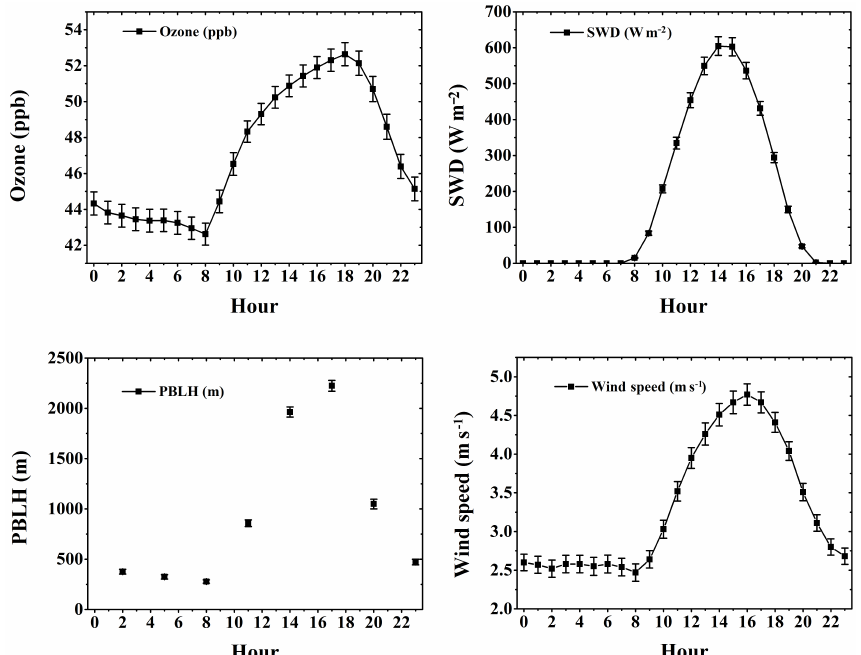
Figure 7. Diurnal variations in hourly average of surface ozone, SWD (downward shortwave radiation), wind speed and PBLH (planetary boundary layer height) during the whole measurement period at Nam Co Station. Error bars show the 95% confidence intervals.